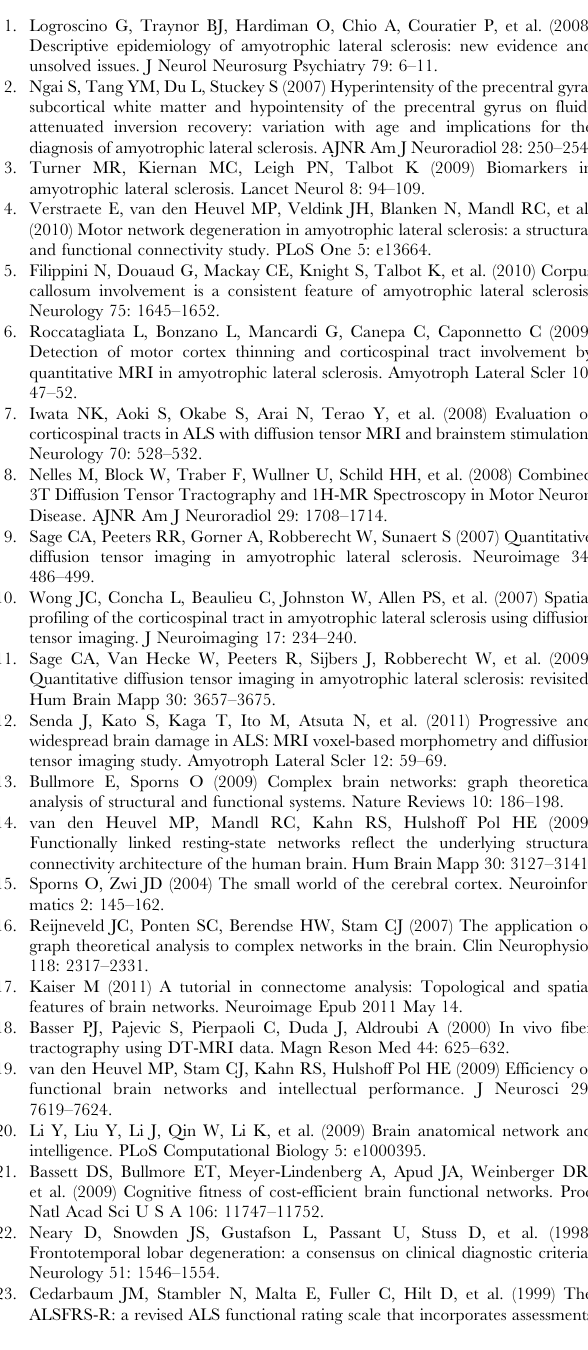
Figure S1 Average connectivity distribution of the group of patients with ALS and the group of healthy